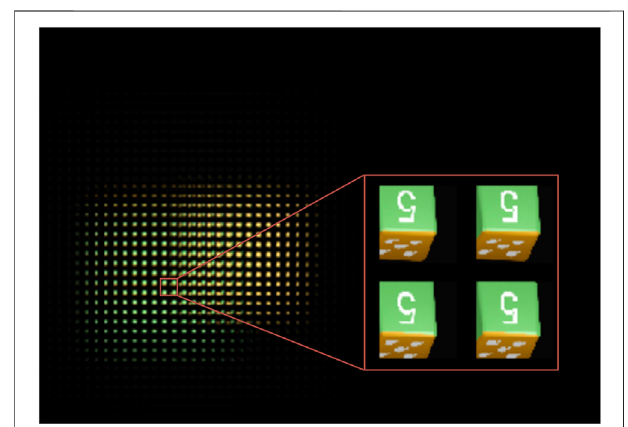
FIGURE 8 | Overall and partial magni fi cation effects of the average SPOC